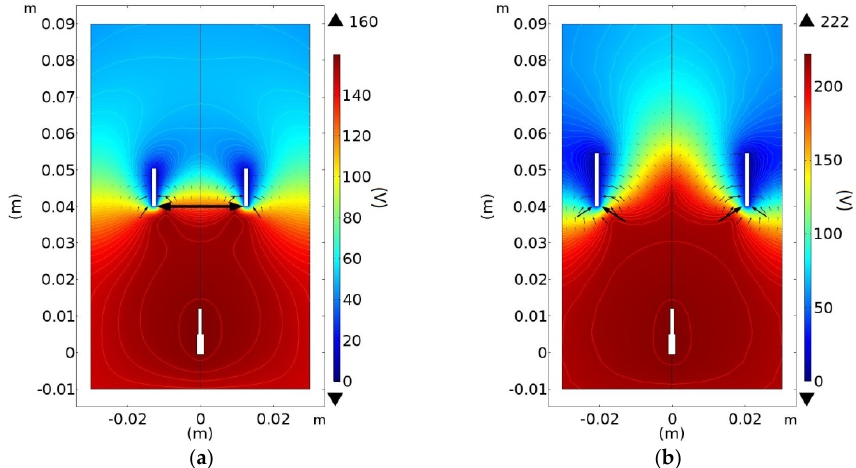
Figure 8. Electric potential distribution (in V units) and electric field (black arrows in V/m units) for the optimal thruster output: ( a ) thruster with argon as propellant gas; ( b ) thruster with xenon as propellant gas.